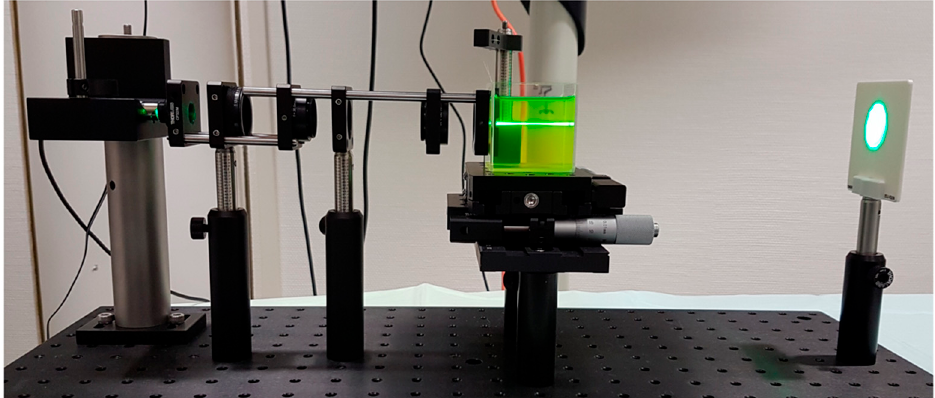
Figure 1. Setup for ray propagation imaging. From left to right, the following setup components are depicted: a monochromatic green laser light source (520 nm) projects through a diaphragm and a beam expander (f1 = 30 mm and f2 = 60 mm). A model cornea is a plano-convex lens (f = 30 mm) placed between the illumination system and the water bath containing a fluorescein solution. An IOL holder is submerged in the fluorescein solution, and a screen is mounted behind the water bath.